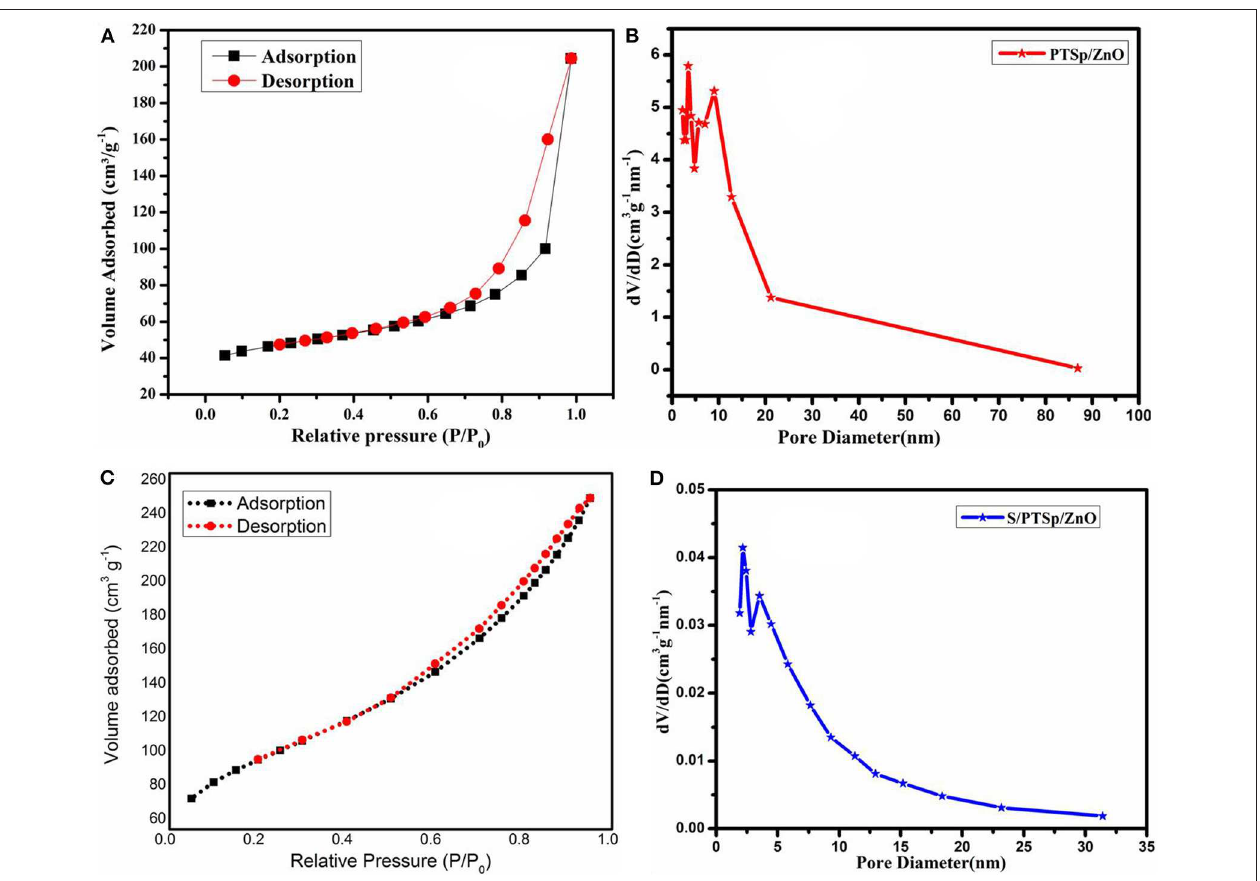
FIGURE 5 | Nitrogen adsorption-desorption isotherms at 77K of (A,C) PT Sp/ZnO and S/PT Sp/ZnO, (B,D) BJH pore size distribution of PT Sp/ZnO and S/PT Sp/ZnO.